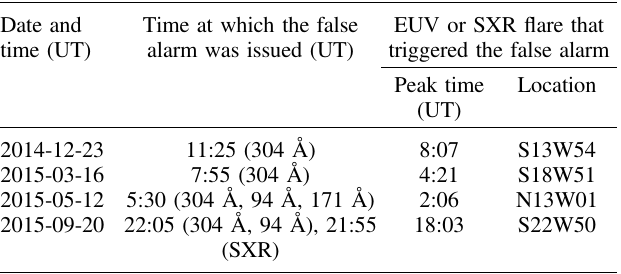
Table 7. False alarms issued by the WCP-euv94, WCP-euv171, WCP-euv304a and WCP-sxr models for predicting the events in Table 1 from November 2014 to December 2017 using out-of-sample